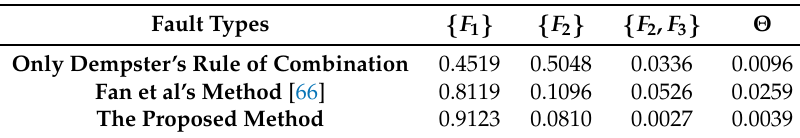
Table 6. Fusion results with different